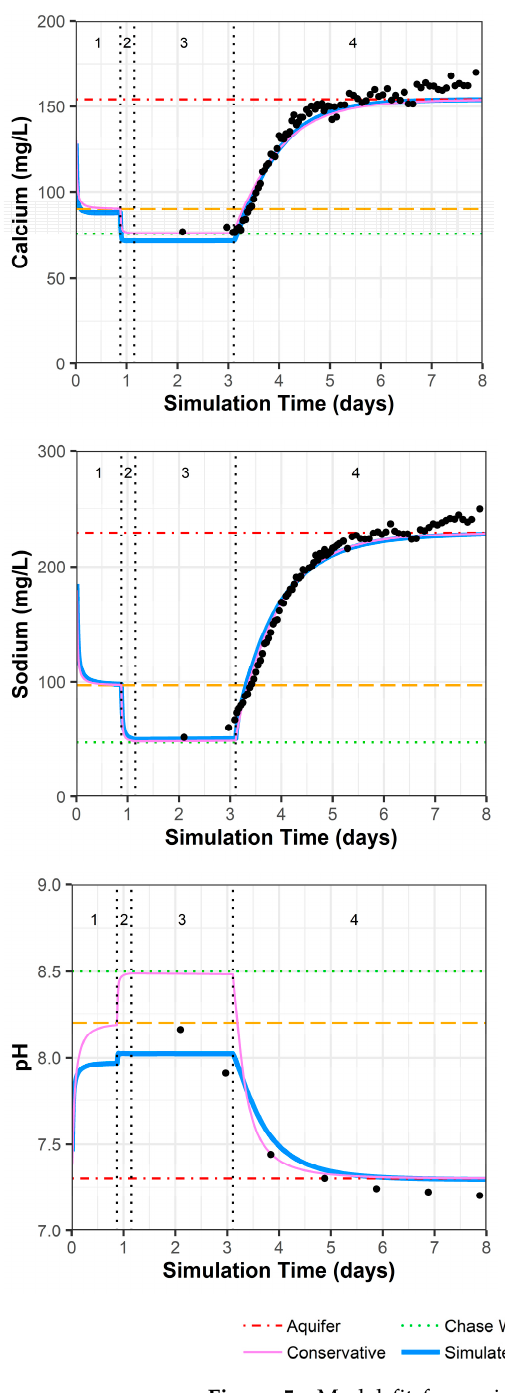
Figure 5. Model fit for various constituents in well 0110 with a multilayer approach. Phases are: (1) traced river water injection, (2) untraced river water injection (chase), (3) drift phase, and (4) pumping